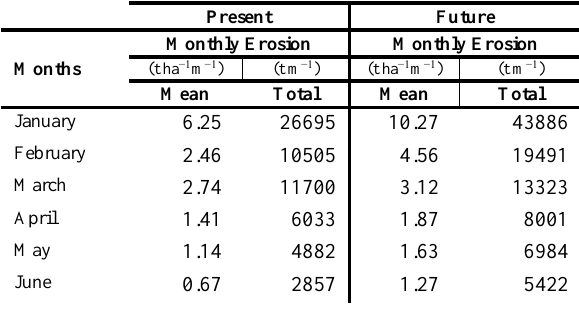
Table 2. Mean total erosion of monthly results of the